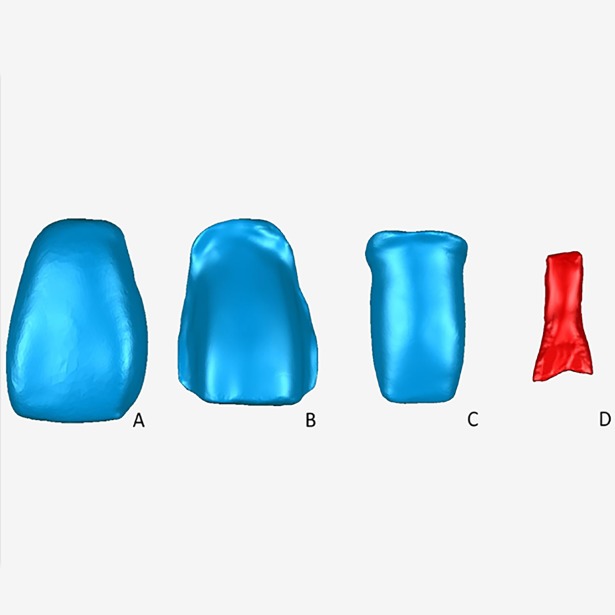
Sketch map for the measurement of specimens of maxillary central incisors after preparation for full-porcelain restoration.(A) The crown of an original specimen; (B) A specimen prepared for porcelain veneer; (C) A specimen prepared for all ceramic crown; (D) Medullary chamber of the crown.